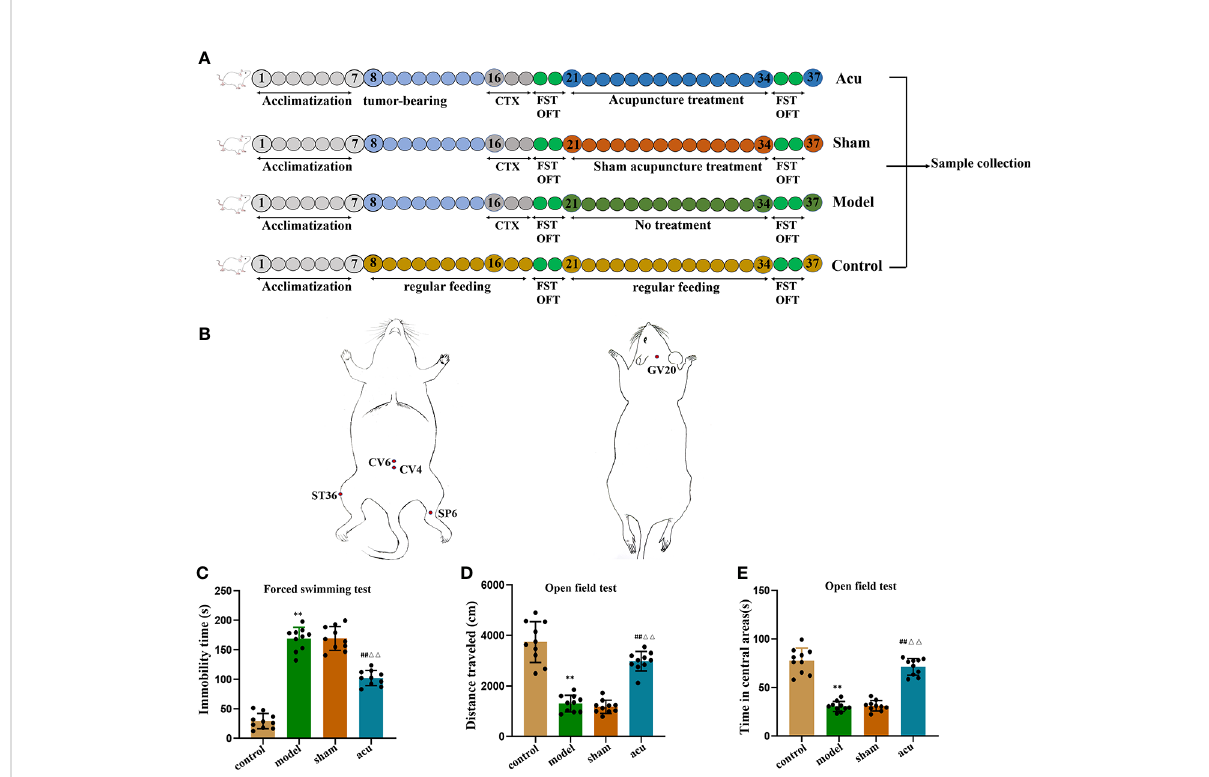
FIGURE 1 Acupuncture treatment exerts anti-fatigue effect in CRF mice after chemotherapy for BC. (A) , Experimental design. After acclimatization for 1 week, mice received tumor bearing for 7days, followed by intraperitoneal injection of CTX for three consecutive days, after behavioral testing, they were divided into acu group, sham group, and model group. The mice in the control group were given regular feeding throughout the whole process. (B) The localization of acupoints selected for acupuncture. (C) After tumor-bearing plus chemotherapy and acupuncture treatment, the forced swimming immobility time were measured in the FST. (D) After tumor-bearing plus chemotherapy and acupuncture treatment, the distance traveled were measured in the OFT. (E) After tumor-bearing plus chemotherapy and acupuncture treatment, the time spent in the central area was measured in the OFT. n = 10 mice in each group. ** P < 0.01 versus control group; ## P < 0.01 versus model group; △△ P < 0.01 versus sham